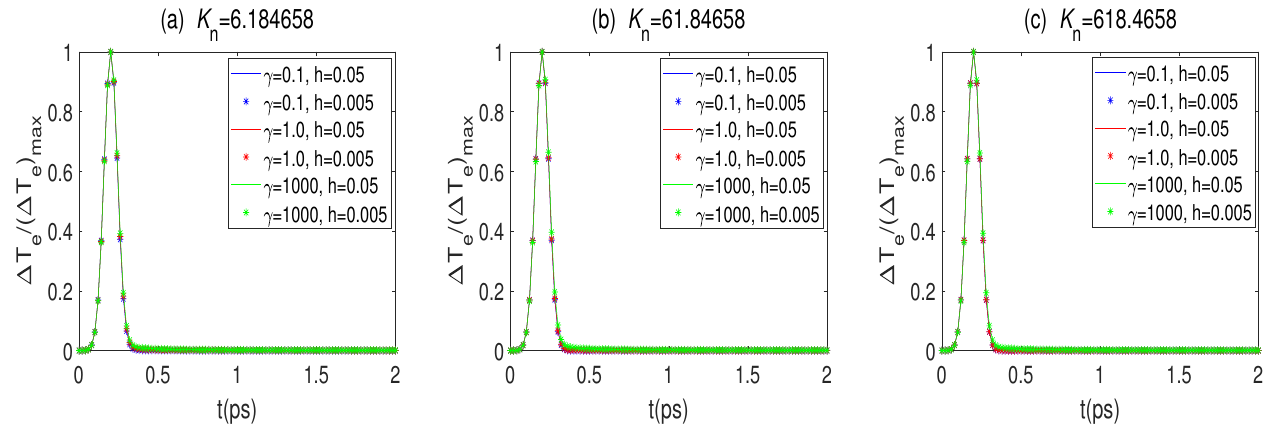
Figure 4. Changes in electron temperature ∆ T e / ( ∆ T e ) max and various K n , γ , and ( α , β ) = ( 0.1,0.1 )